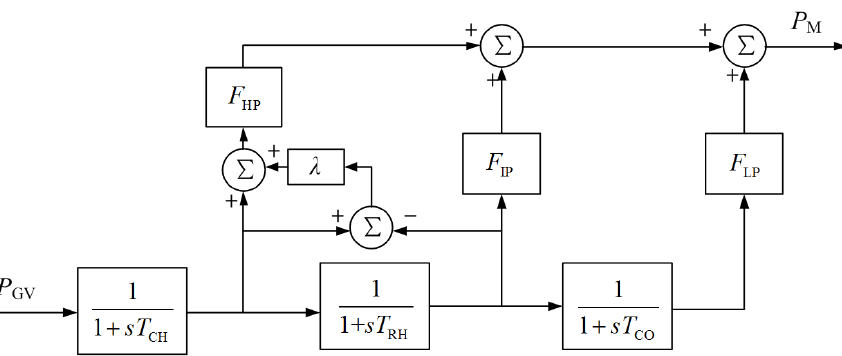
Figure 5. The classical model of reheat condensing steam